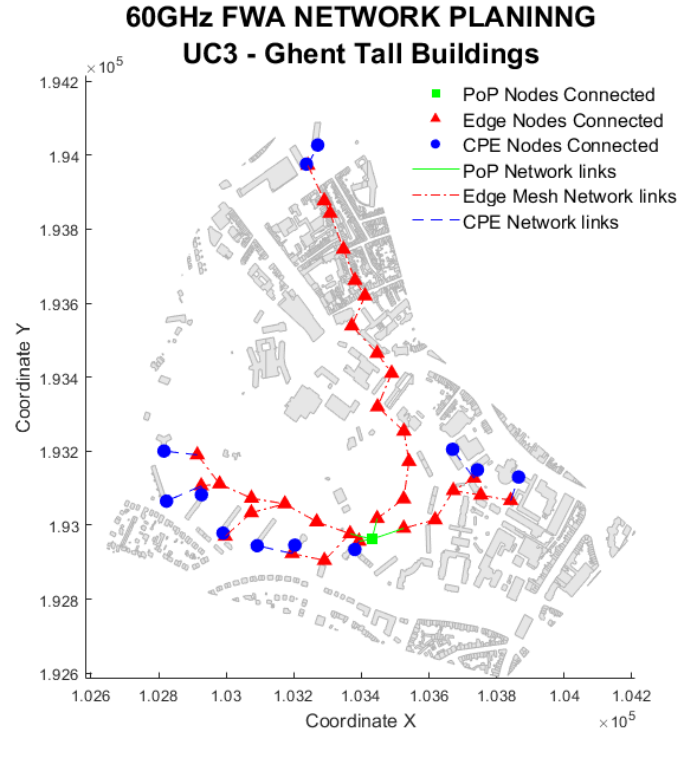
Figure 12. Use Case 3 solution example. Snapshot of the urban Ghent